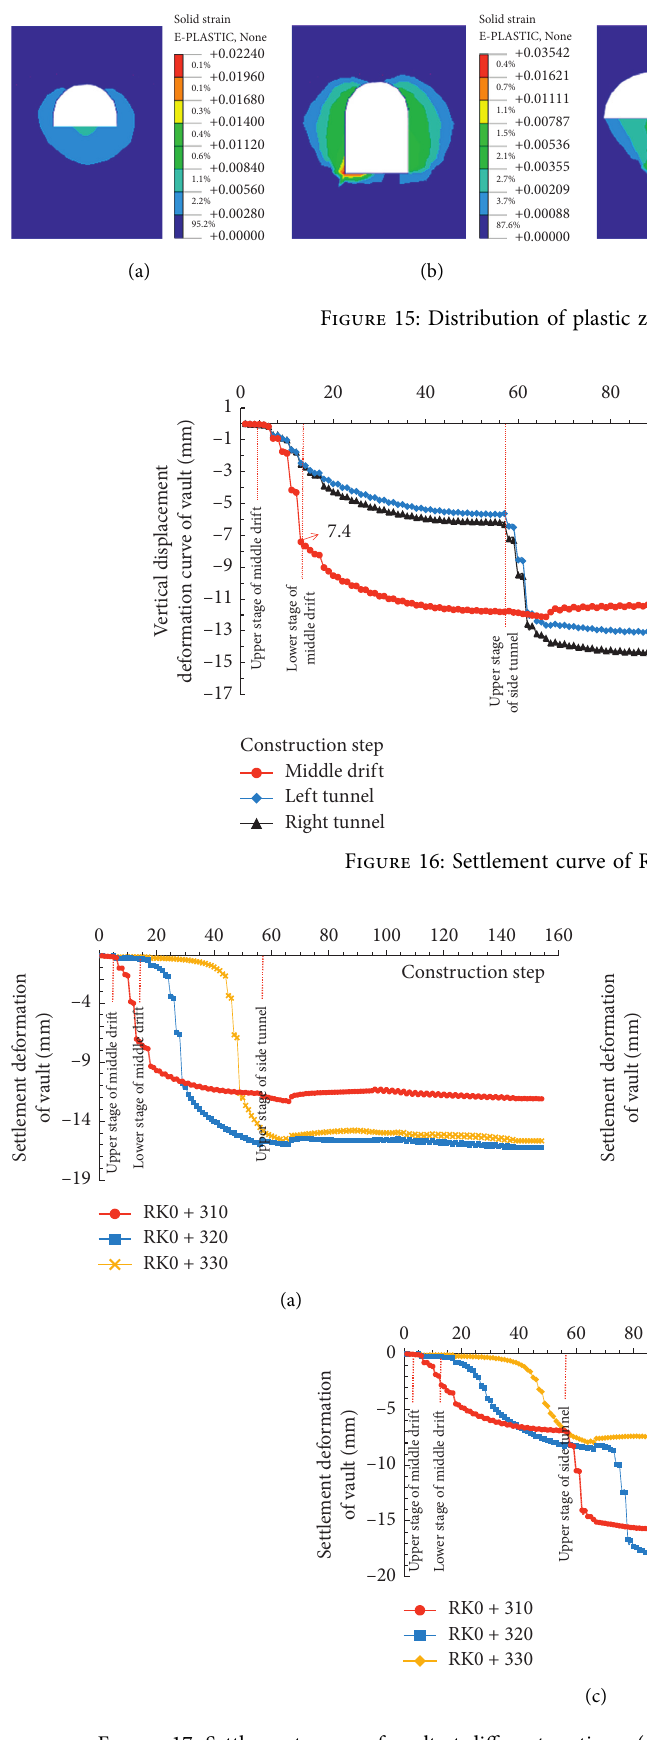
Figure 17: Settlement curve of vault at different sections. (a) Middle drift. (b) Left tunnel. (c) Right